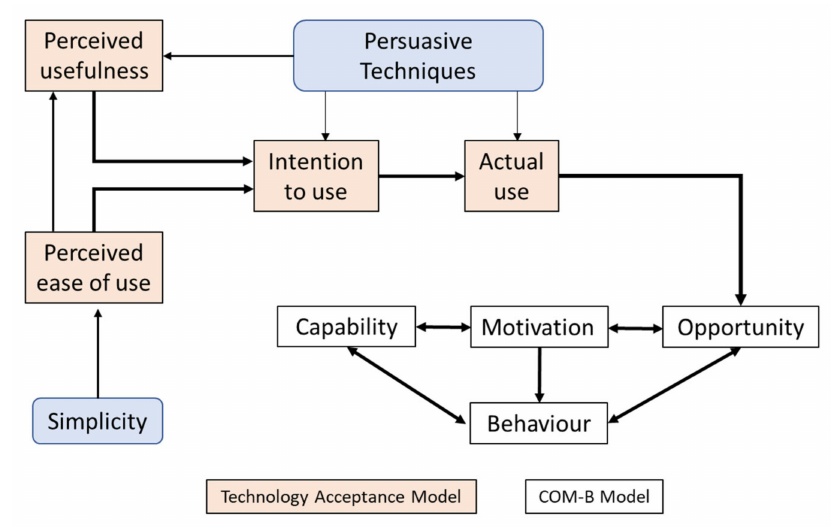
Figure 2. Conceptual framework of